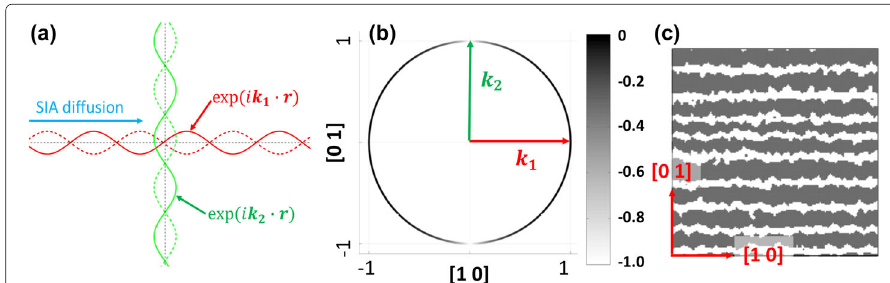
Fig. 2 (Color online) a 1D SIA diffusion and two perturbation waves in c v (solid curves) and c i (dash); b normalized change in recombination ( σ k λ ); c Atomic configuration at 2.4 dpa from an AKMC simulation showing the development of a k 2 wave. The simulation cell size is 160 × 160 a 2 0 (a 0 is the matrix lattice parameter)